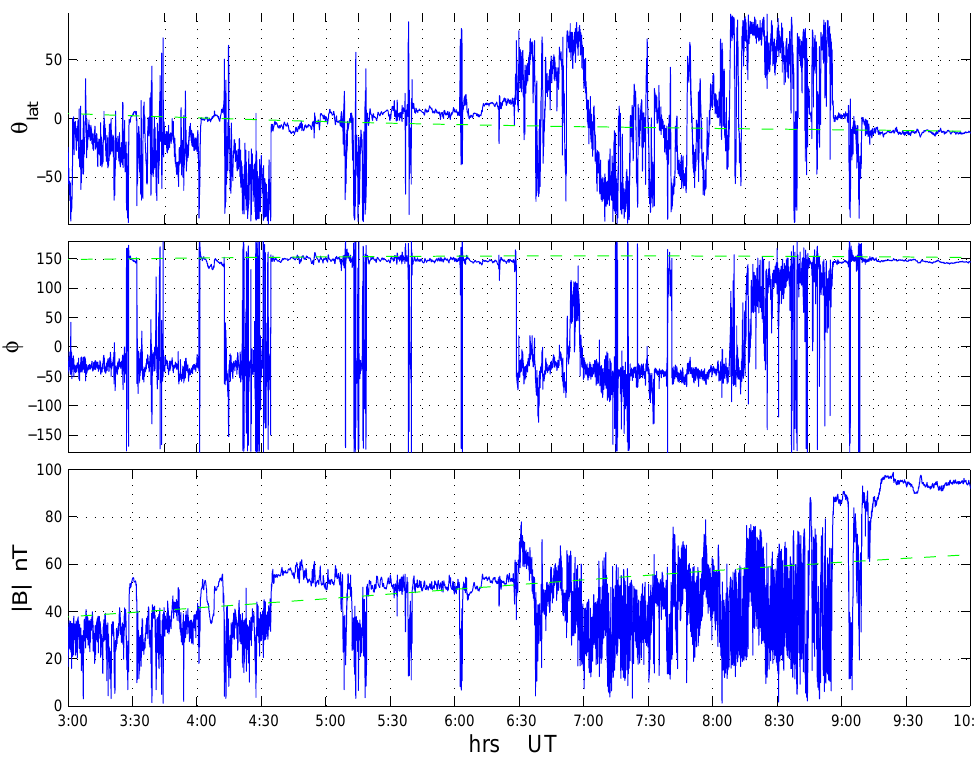
Fig. 3. Plot of the magnetic field measured on spacecraft 4 in GSE polar coordinates. The model field, computed using the Tsganenko-89 model for an extreme activity level ( K P = 6), is shown as dashed lines. The measured field shows high compression after the 09:00 UT crossing. The orientation of the model field fits the data very well, except just before the 06:30 UT crossing.